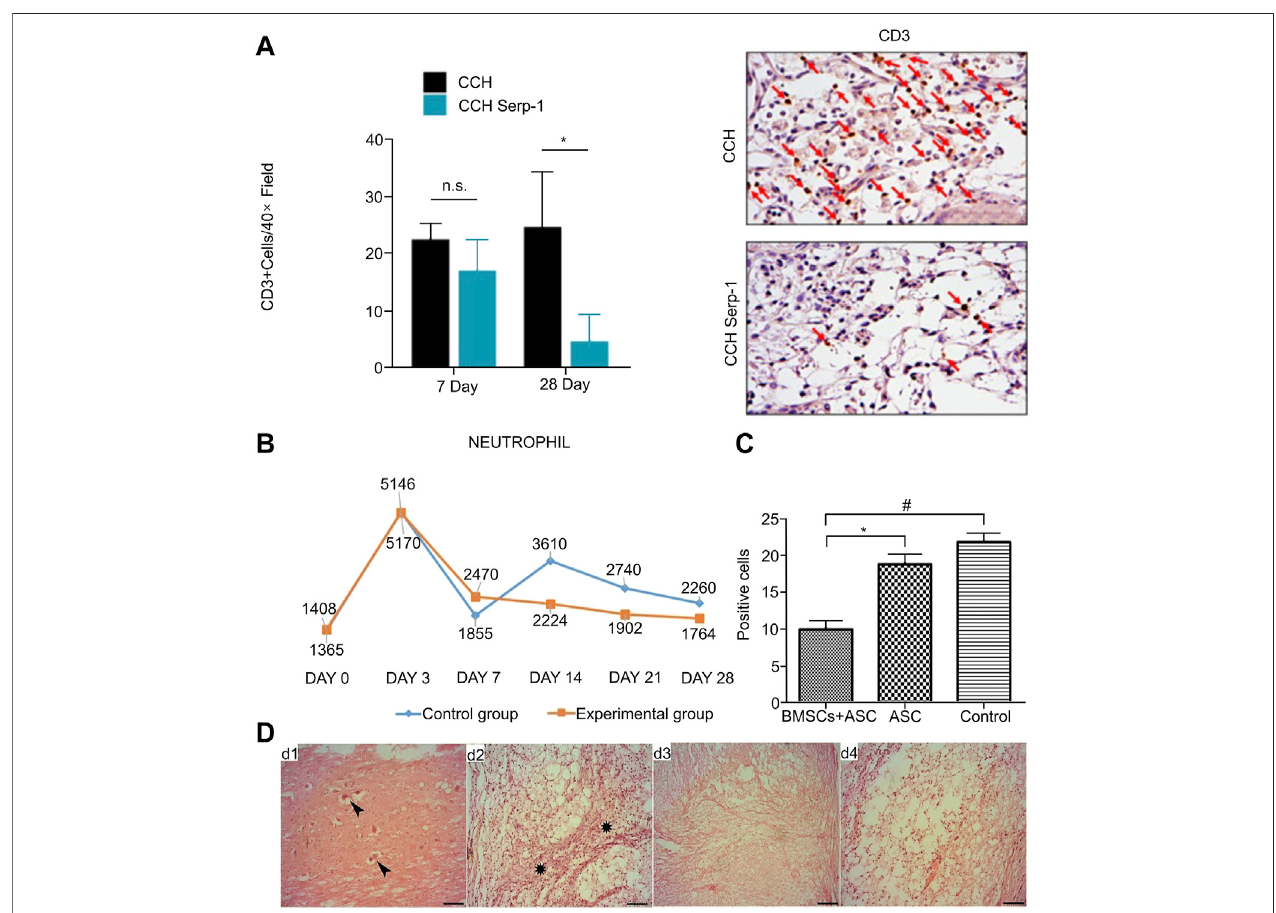
FIGURE 3 | Regulation of neutrophils and lymphocytes by biological materials. (A) Quantitative analysis of CD3+ cells in different treatment groups and immunohistochemicalstainingofCD3+cellsonday28underthesameconditions. (B) Changesofneutrophils(106/L)intheexperimentalgroupandthecontrolgroupat differenttime periods. (C) Tlymphocytes(CD5)showingsigni fi cantdifferencesfortheBMSCs+ASCgroupcompared withtheASCgroup(* p < 0.05)andcontrolgroup (# p < 0.05) at 2 weeks after surgery. (D) Histological characteristics of different groups on the 28th day after operation. d1 and d2 were controls: fi brotic tissue in fi ltration and neuron necrosis were seen. d3 and d4 were experimental groups: the injury site was fi lled with neatly arranged white matter fi bers and mild in fl ammation. Reproduced with permission from (82, 84, 86).